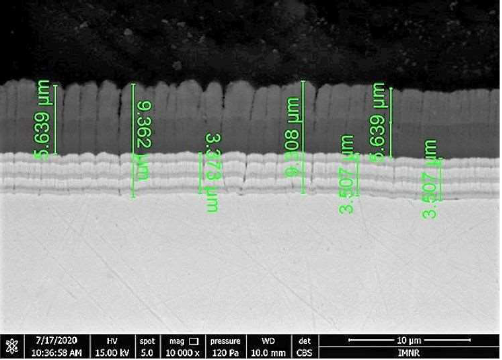
Figure 8. Cross-sectional analyses of the coated specimen: SEM ( a ) and EDS ( b ).